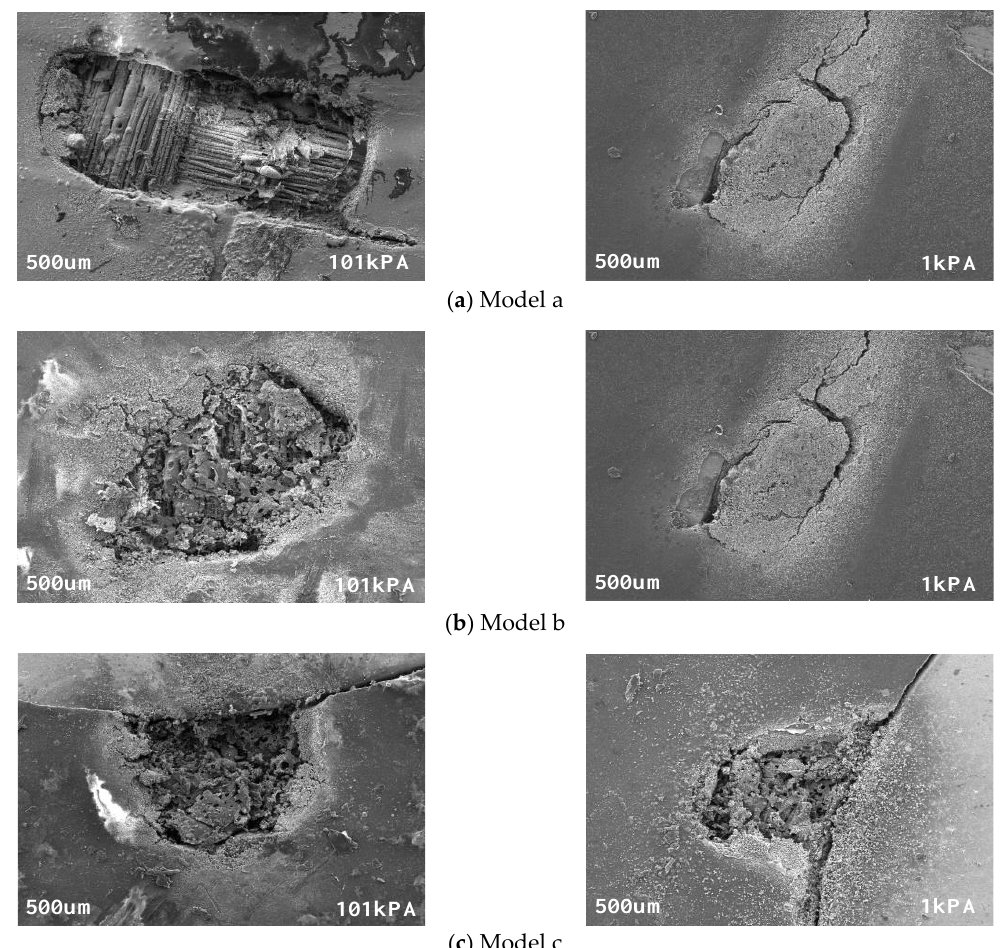
Figure 9. Surface morphology of the PCB breakdown channel by SEM under different pressures.